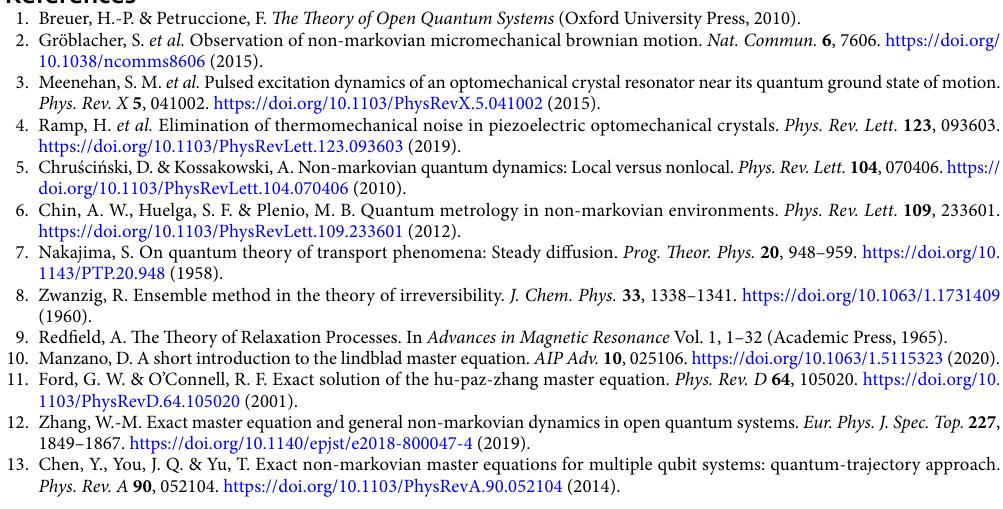
Figure 2. Dynamics of two-time correlation functions in the short-time limit for 5 and ( c ) t 10 , in the Markov limit (blue dashed line), and non-Markovian regime (red conditions: ( a ) t ′ ′ = = solid line). The corresponding Fourier spectral functions are shown in ( b , d ) respectively. Other parameters are 1 , Ŵ 1 chosen as ω = =